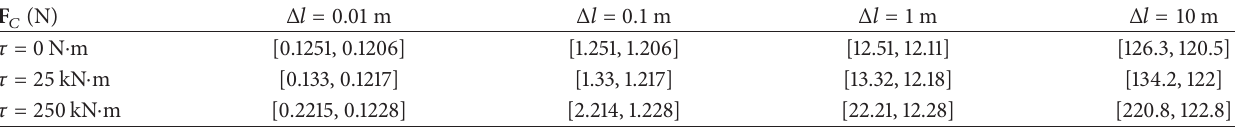
Table 1: The change range of F 𝐶 with difference in tethers’ length and different external torque value.